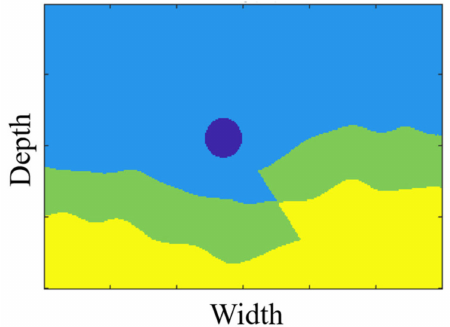
Figure A8. Model with folds, random fluctuations, faults, and